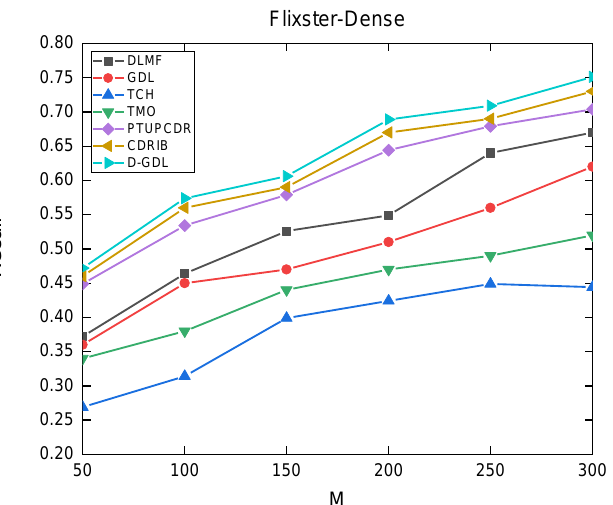
Figure A7. Performance of D-GDL against the comparative approaches based on Recall vs. M for Netflix dataset in the dense setting.